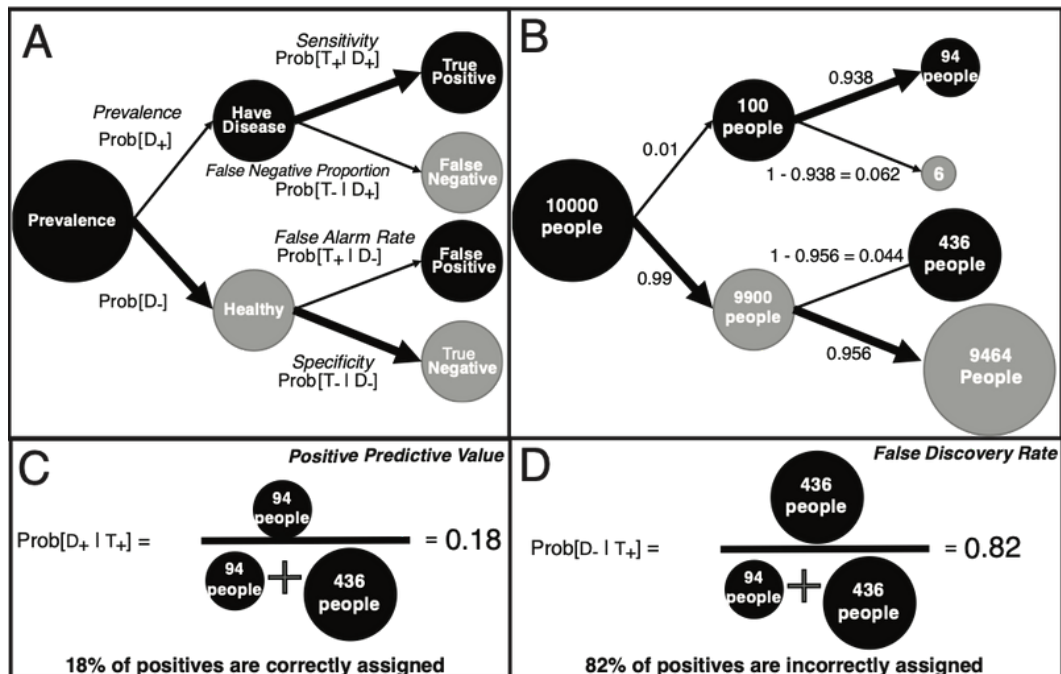
Figure 3. A tree of possible events. (A) Events delineated based on probability notation and epidemiological terms. (B) The expected distribution of 10,000 people through this tree of events when prevalence is 1%, sensitivity is 93.8%, and specificity is 95.6% (based on specifications of the first antibody test to achieve Food and Drug Administration [FDA] emergency use authorization). The probabilities and numbers can be used to calculate (C) the positive predictive value, and (D) the false discovery rate.